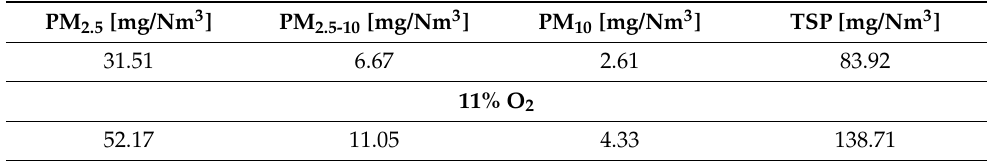
Table 7. Total Suspended Particles and PM